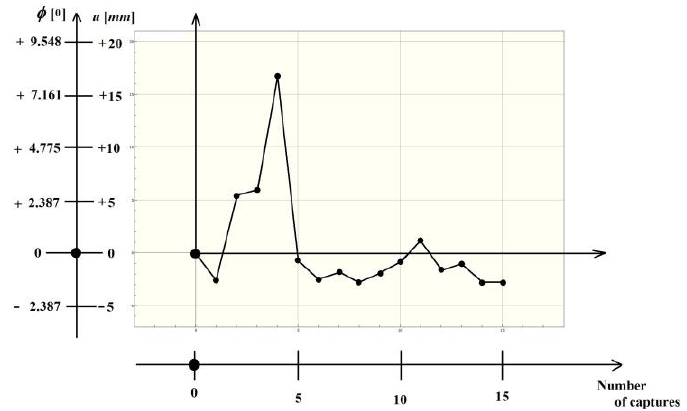
Figure 19. Diagram of variation of the linear displacement 0 u and of the corresponding torsion angle  for the case of the solitary operation of the right motor.